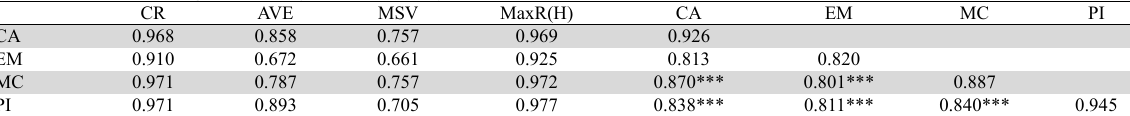
Tests results of convergent validity and reliability